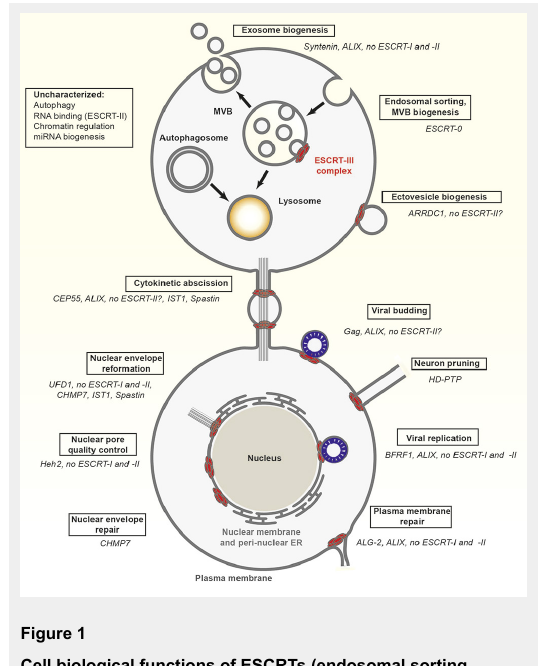
Figure 1 Cell biological functions of ESCRTs (endosomal sorting complexes required for transport). Overview of ESCRT functions throughout the cell. Factors that are specific for each ESCRT-dependent process (boxed) are listed in